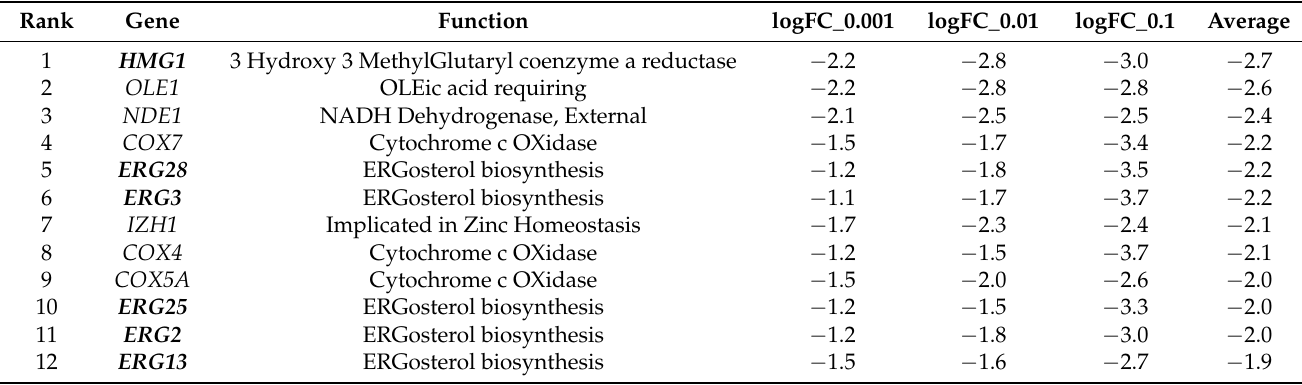
Table 3. Differentially expressed top-30 hit genes in response to MMS (FC,